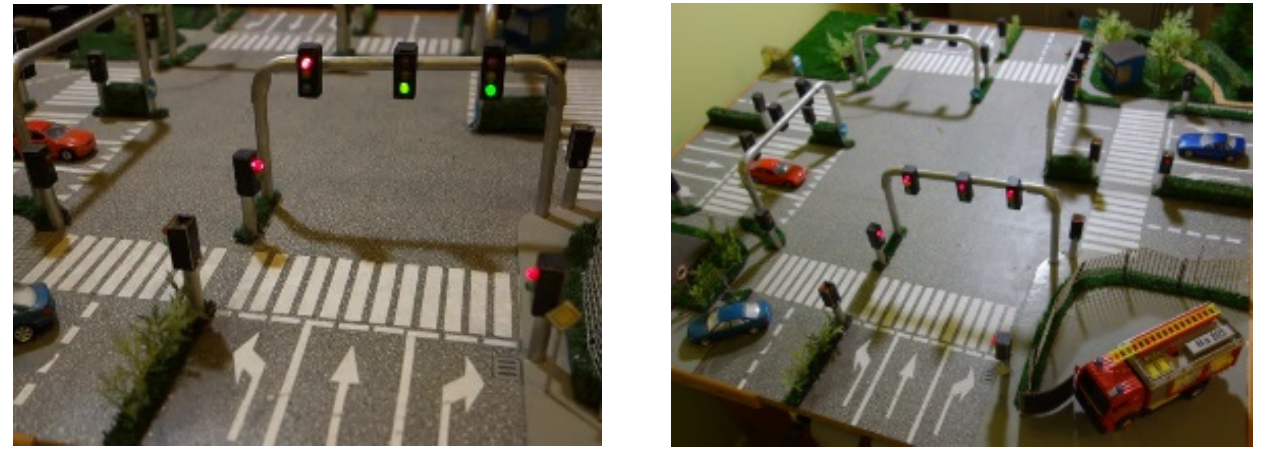
Figure 7. The miniaturization model of the traffic light controller.